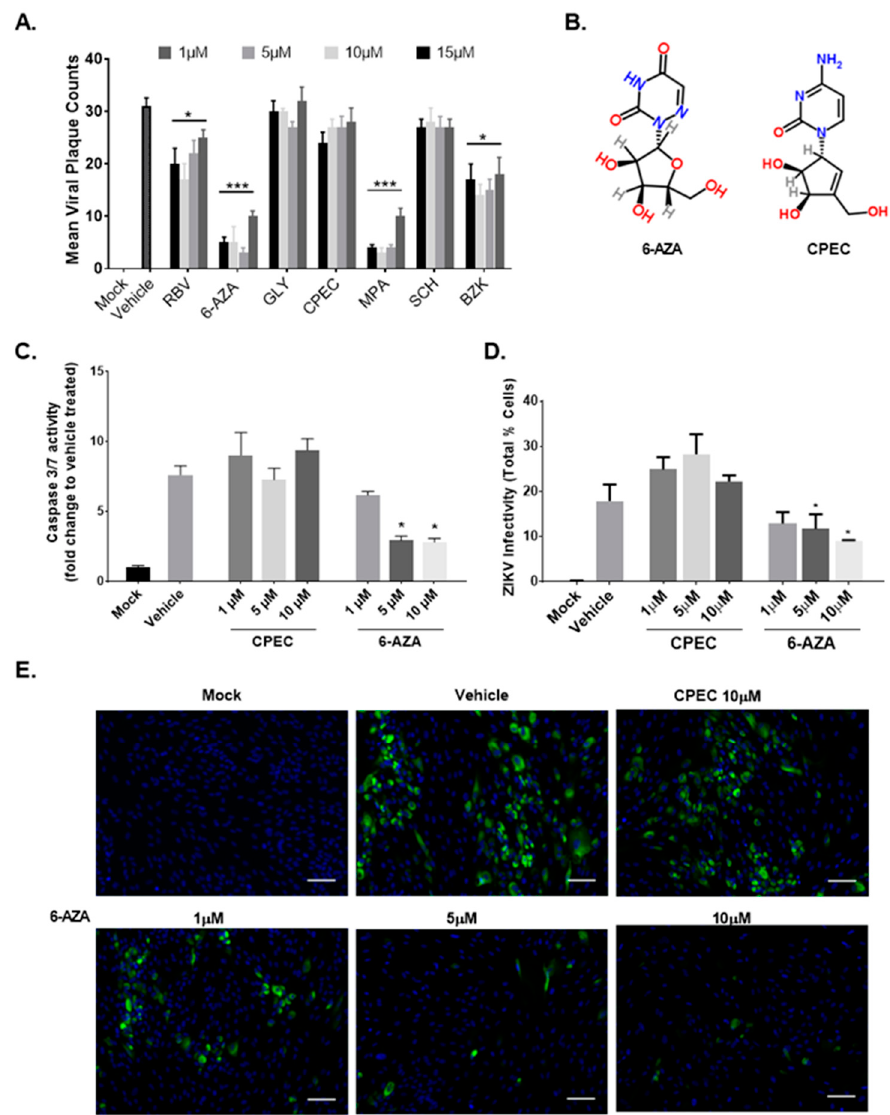
Figure 4. 6-Azauridine inhibits ZIKV replication in FRPE cells. ( A ) Mean Zika viral plaque counts after an antiviral chemical compound screen in Vero cells. RBV (ribavirin); 6-AZA (6-Azauridine); GLY (Glycyrrhizin); CPEC (cyclopentenyl cytosine); MPA (mycophenolic acid); SCH (sodium cholate hydrate); BZK (benzalkonium chloride). Two-way ANOVA followed by Bonferroni test was performed. ( B ) Chemical compound structures of 6-AZA and CPEC. ( C ) Caspase 3/7 activity measured for mock (control), ZIKV infected FRPE cells (vehicle treated) (MOI of 1), and infected and treated FRPE cells with CPEC and 6-AZA at 1, 5, and 10 µM concentrations. ( D ) The percentage of ZIKV infected FRPE cells (% cells) as measured by immunofluorescence assay for detection of ZIKV Env. ( E ) Immunofluorescence images of mock, vehicle, and ZIKV infected and drug treated cells. Treatment with 6-AZA shows a dose dependent anti-viral effect in FRPE cells. Scale bar: 100 µ m. Student t-test was performed for statistical significance if the p -value was p < 0.05 (*); p < 0.0001 (***). Representative data from three independent experiments are